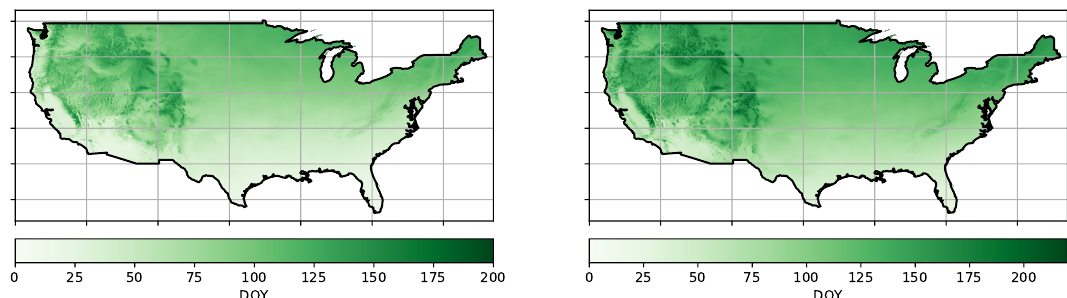
Figure 7. Average of phenology products: Leaf [l] and Bloom [r] from 1989 to 2014.